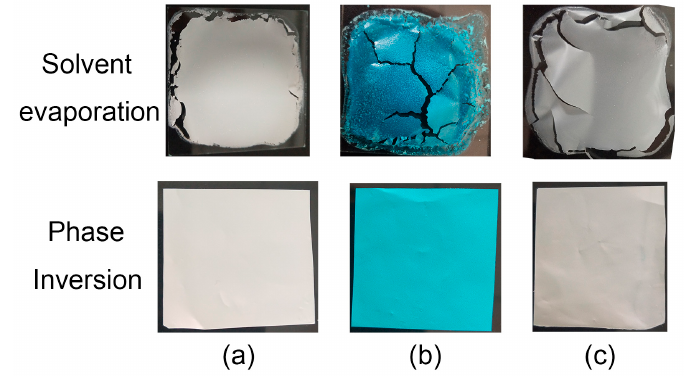
Figure 1. Optical images of ( a ) ZIF-8 / PES, ( b ) HKUST-1 / PES, and ( c ) UiO-66 / PES composite materials prepared via solvent evaporation (top panels) and the solvent exchange method (lower panels). The solvent was DMF.